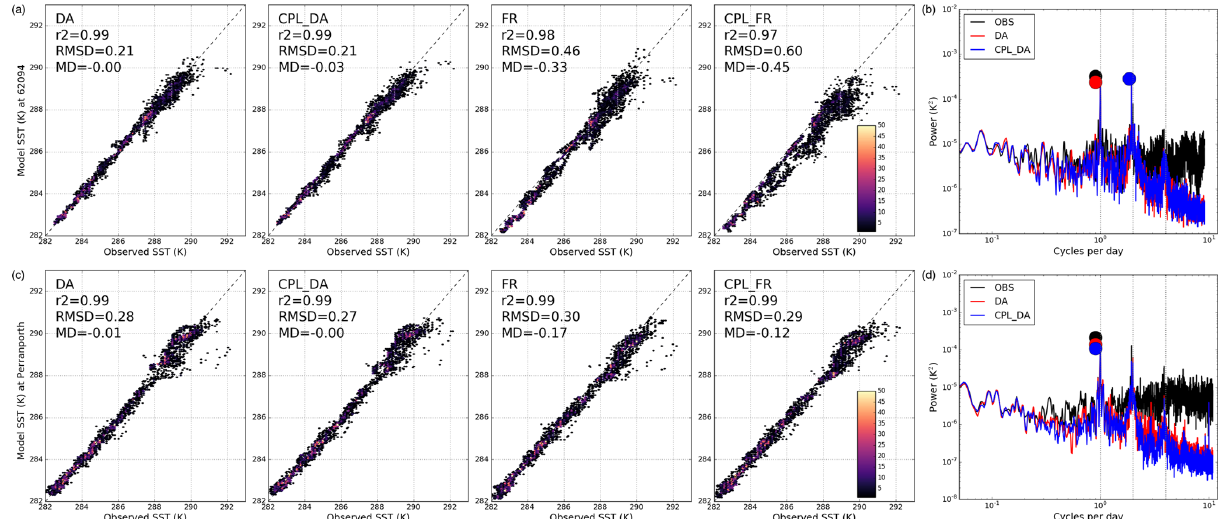
Figure 6. (a) Scatter plots comparing hourly simulated SST during 2017 from DA, CPL_DA, FR, and CPL_FR simulations with observed values in the Celtic Sea (buoy 62094; marked CS in Fig. 3a). Summary r 2 correlation coefficient, RMSD, and MD (Model minus Observation) statistics are listed for each model run. Shading reflects the number of points within data bins. (b) Computed power spectra ( K 2 ) for observed, DA and CPL_DA simulated SST at the Celtic Sea location. Filled circles highlight the amplitude of the peak power for each time series. Vertical dotted lines mark diurnal, semi-diurnal, and quarter-diurnal frequencies. (c) Scatter plots comparing model and observed SST and (d) power spectra computed for time series at the Perranporth coastal buoy (marked PP in Fig.